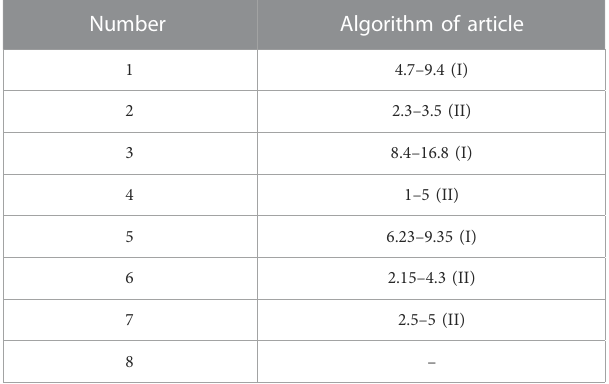
TABLE 4 Sample corrosion evaluation results. Soil type Evaluation matrix Y